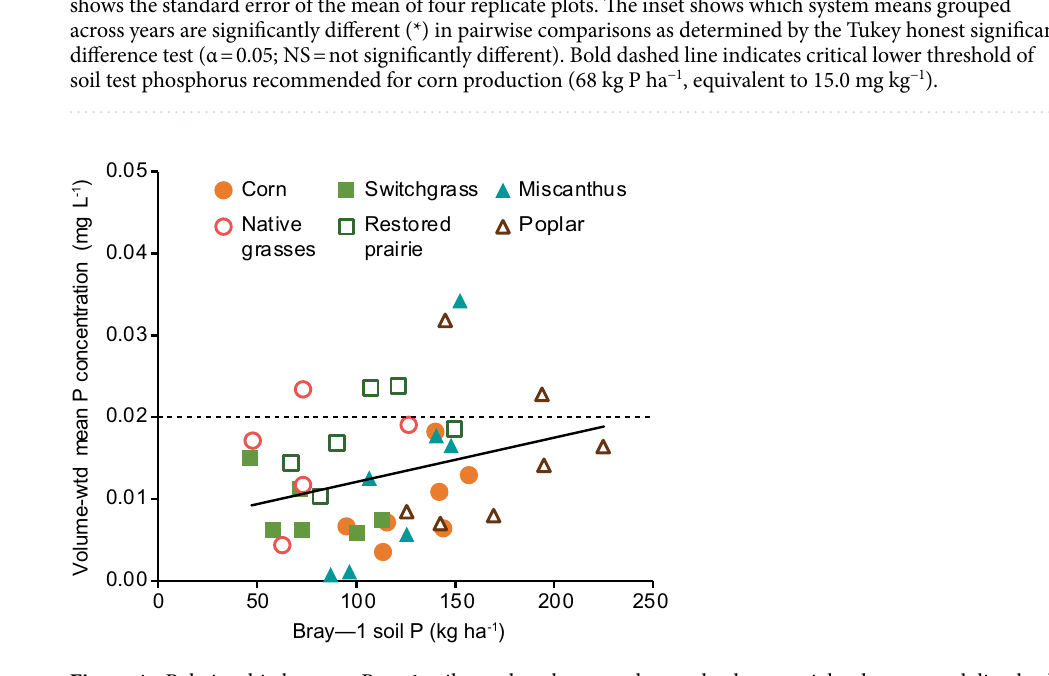
Figure 4. Relationship between Bray-1 soil test phosphorus and annual volume-weighted mean total dissolved phosphorus concentrations in leachate. The correlation is significant for all data combined (p < 0.05; r = 0.34). Dashed line indicates the critical total phosphorus concentration above which surface waters are prone to eutrophication 3,16